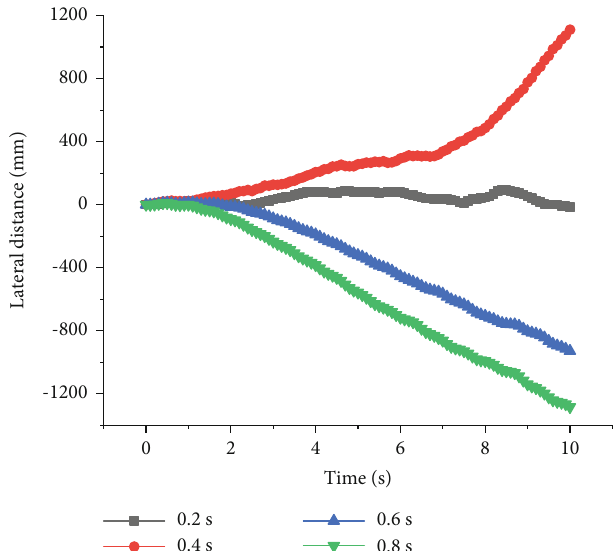
Figure 5: Lateral distances of quadruped robots with elbow joint for front legs and knee joint for back legs with di ff erent period at a constant